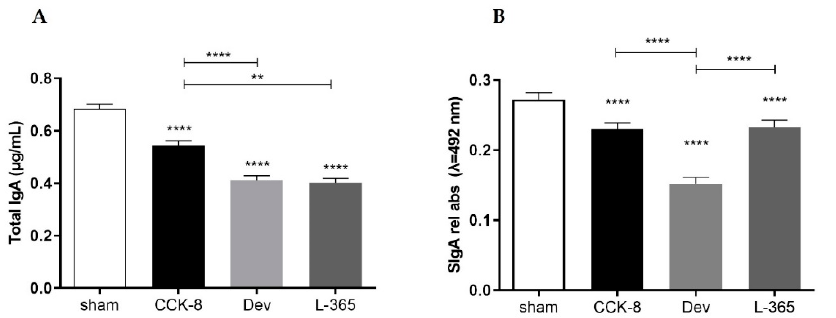
Figure 1. Total IgA ( µ g/mL) ( A ) and SIgA (relative absorbance λ = 492 nm) ( B ) in intestinal secretions from the small intestine were assessed in the following groups: sham, CCK8, devazepide and L365,260. The results from one representative experiment (from three replicates) with eight mice per group are expressed as the mean and standard deviation (SD). ** p < 0.01 and **** p < 0.0001 upon column comparisons vs. control group or upon line comparisons among the CCK8, devazepide and L365,260 groups.